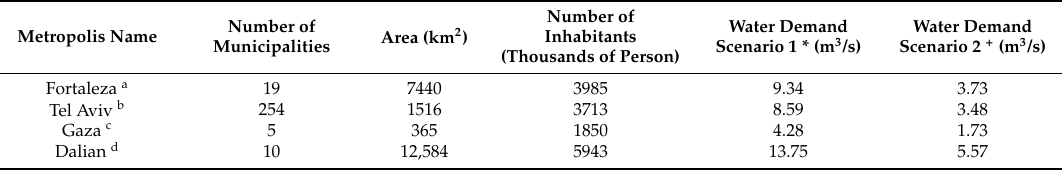
Table 1. Regions Metropolitan and Rivers